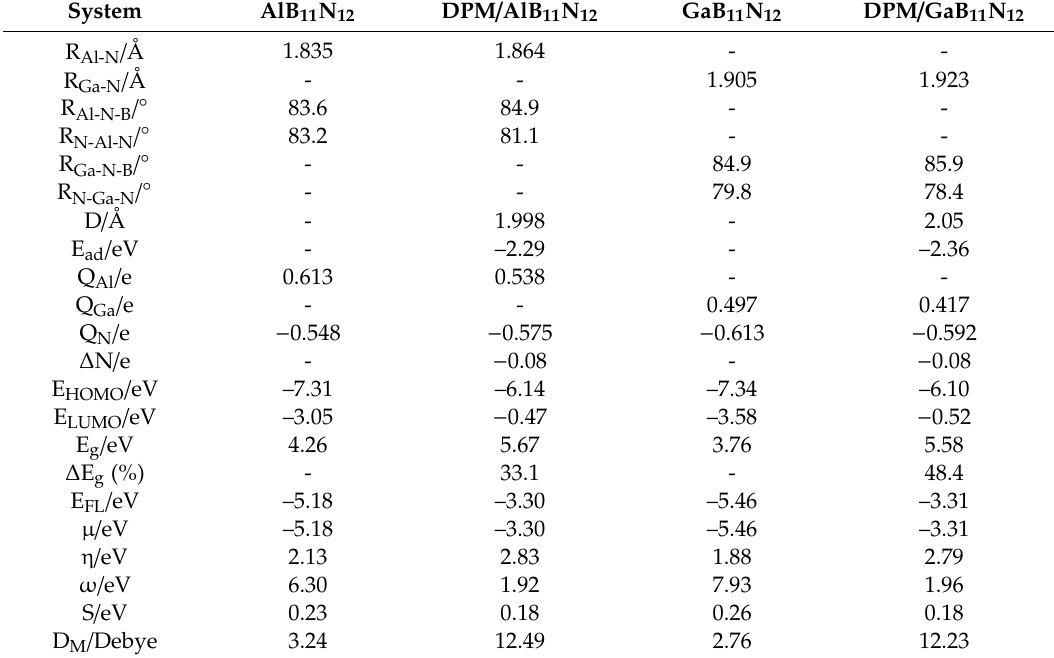
Table 3. Calculated adsorption energy (E ad ), charge (e), HOMO and LUMO energies (E HOMO and E LUMO ), Fermi level energies (E F ), energy gap (E g ), dipole moment (D M ), and quantum molecular descriptors for optimized geometries of the DPM with Al- and Ga-doped B 12 N 12 nano-cages in the gas